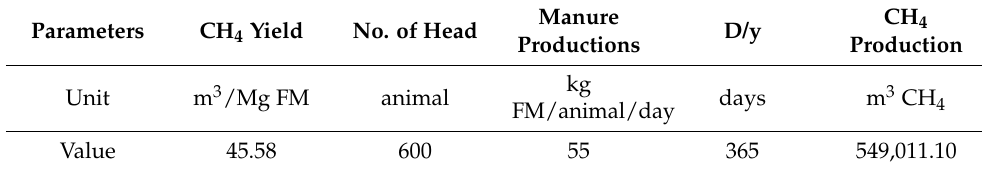
Table 6. Methane production per year from solid fraction of cow manure.